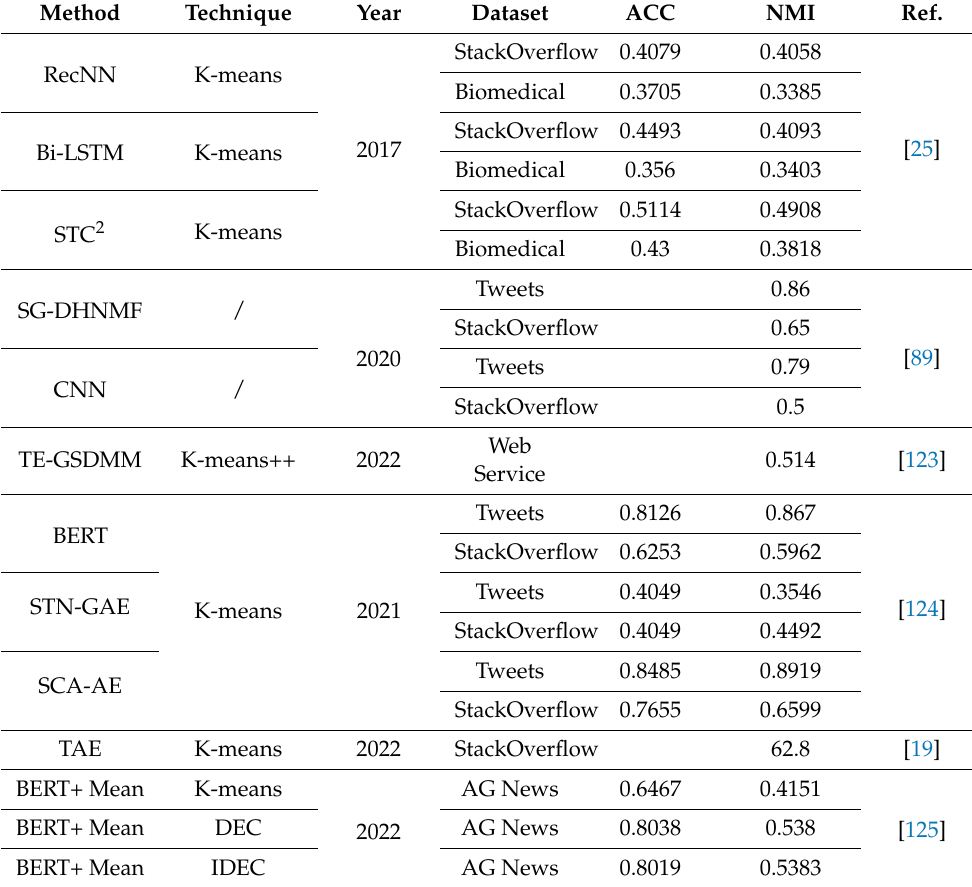
Table 3. Analysis of the studies on the deep learning similarity